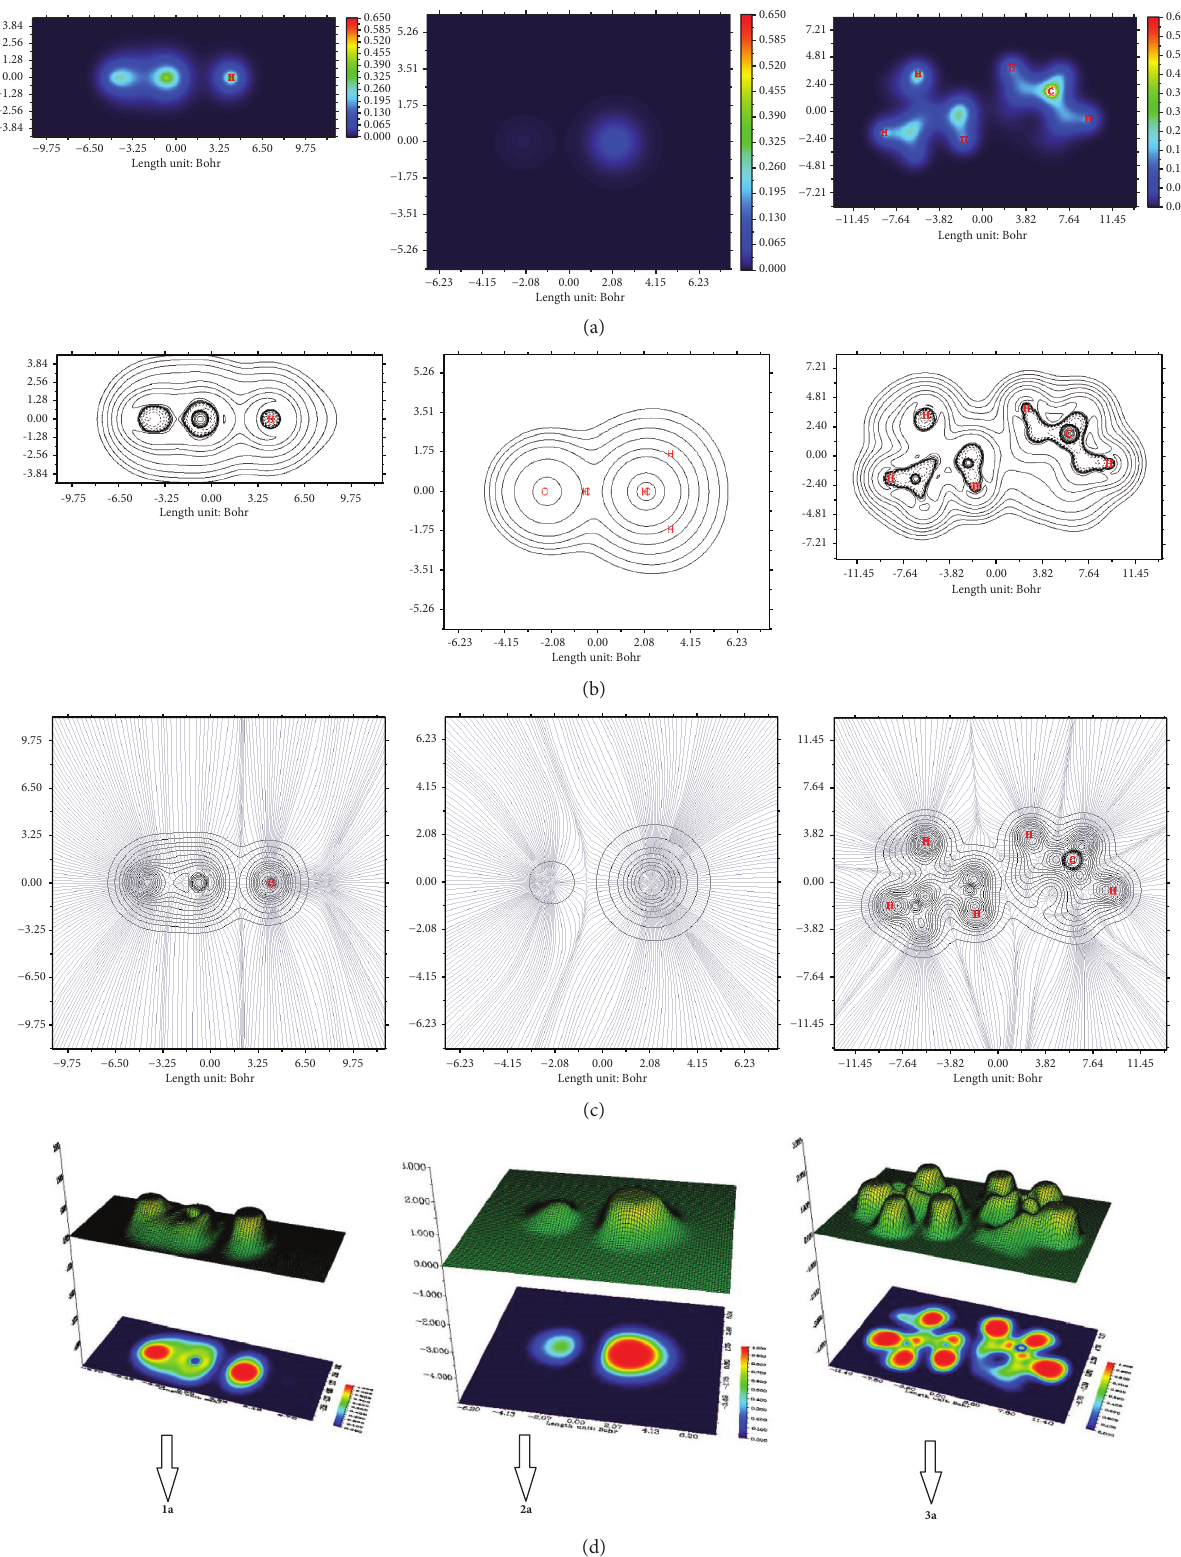
Figure 6: Contour map of (a) electron density, (b) electron density Laplacian, (c) LOL, and (d) ELF of 1a, 2a, and 3a